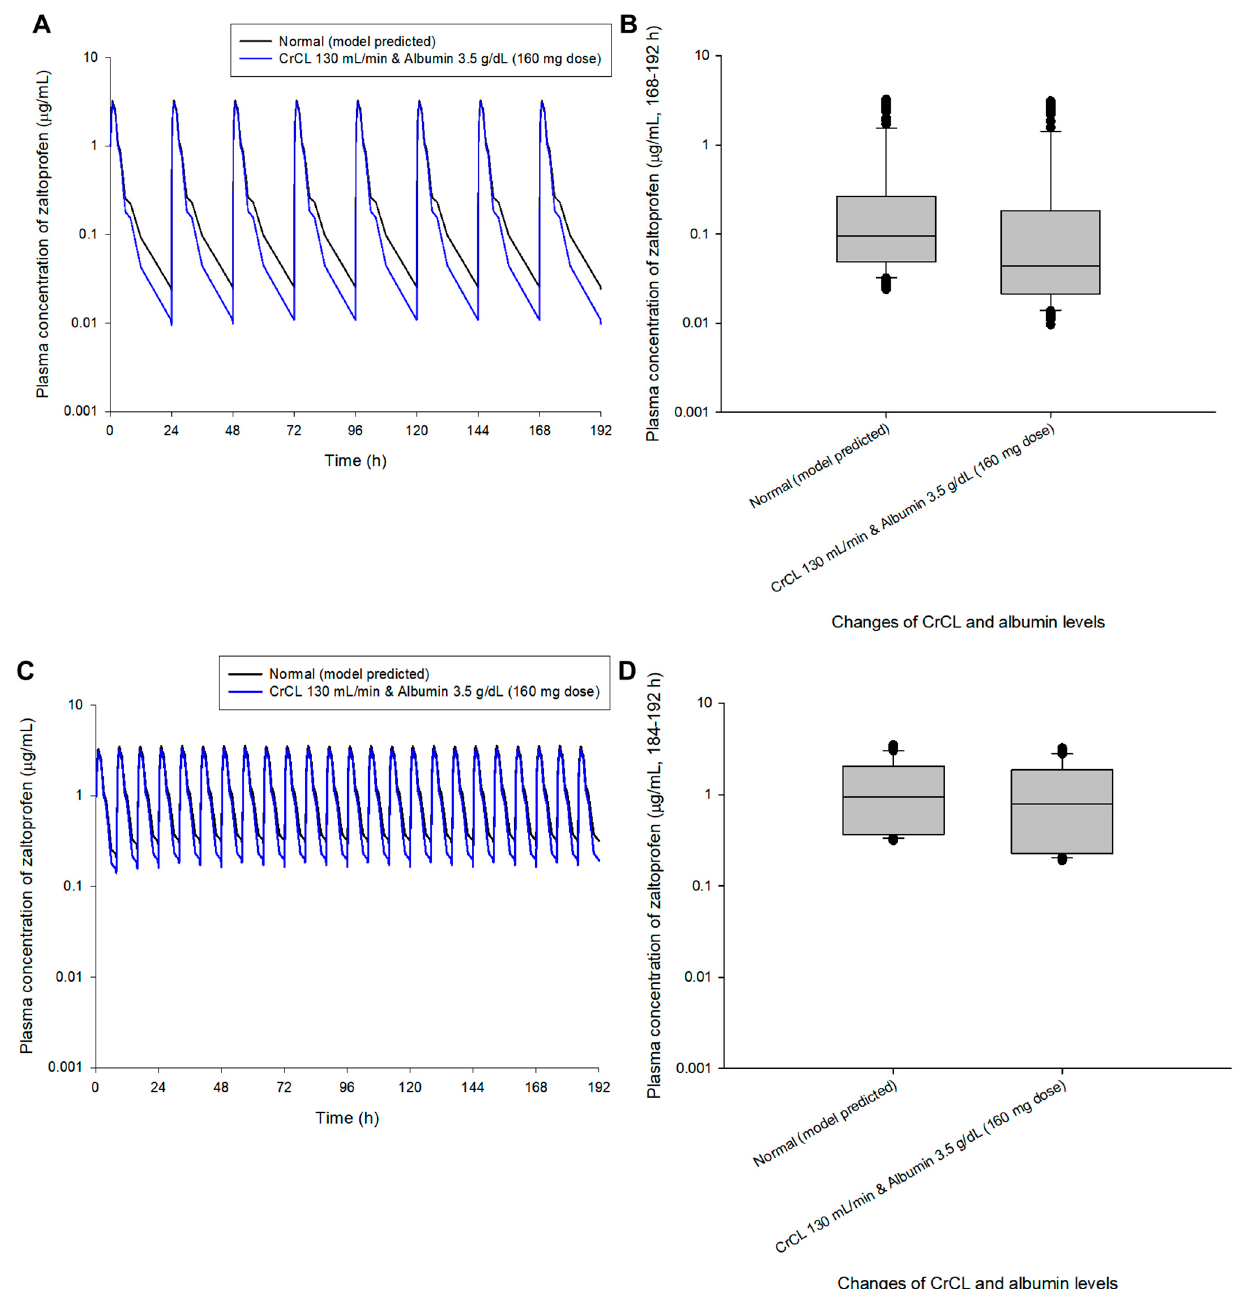
Figure 5. Simulation of the pharmacokinetic prediction profile after multiple (24 h ( A , B ) and 8 h intervals ( C , D )) oral administrations of zaltoprofen predicted by arbitrarily adjusting the dose to 160 mg for the group with CrCL and albumin levels of 130 mL/min and 3.5 g/dL, respectively. The lines in the graph ( A , C ) indicate the mean values corresponding to 50% of each group. Normal in the graph indicates the 50% average predicted by the model established in this study (based on the group with median values of CrCL and albumin of 104.38 mL/min and 4.90 g/dL, respectively). Comparison ( B , D ) of predicted intergroup plasma concentrations at steady-state (168–192 h ( B ) and 184–192 h ( C )) following a dose change of zaltoprofen to 160 mg for a group with CrCL and albumin levels of 130 mL/min and 3.5 g/dL, respectively.